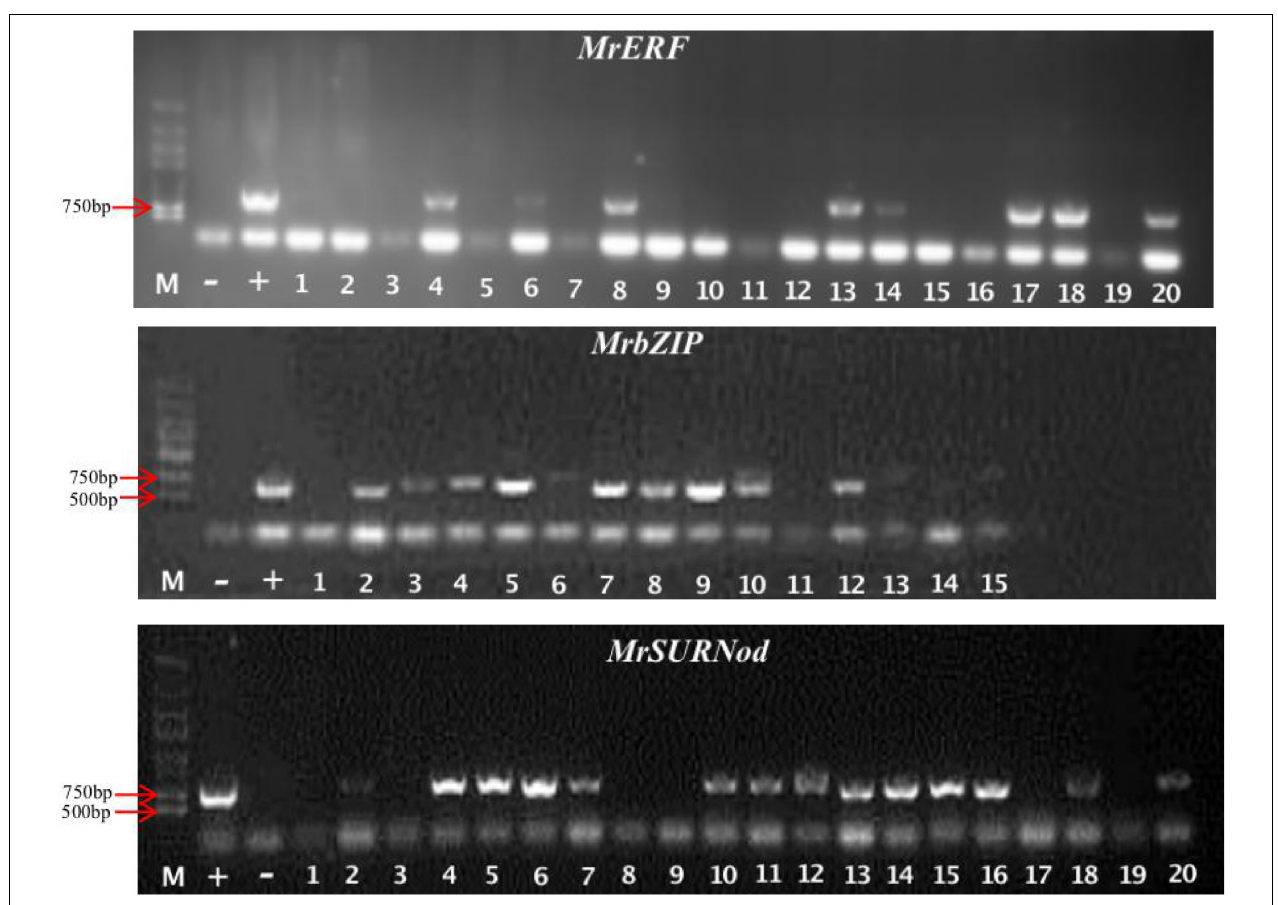
FIGURE 2 | Identification of tobacco transgenic lines by PCR. “M”, Marker (DL2000); “ – ”, negative control; “ + ”, positive control, the rest were transgenic